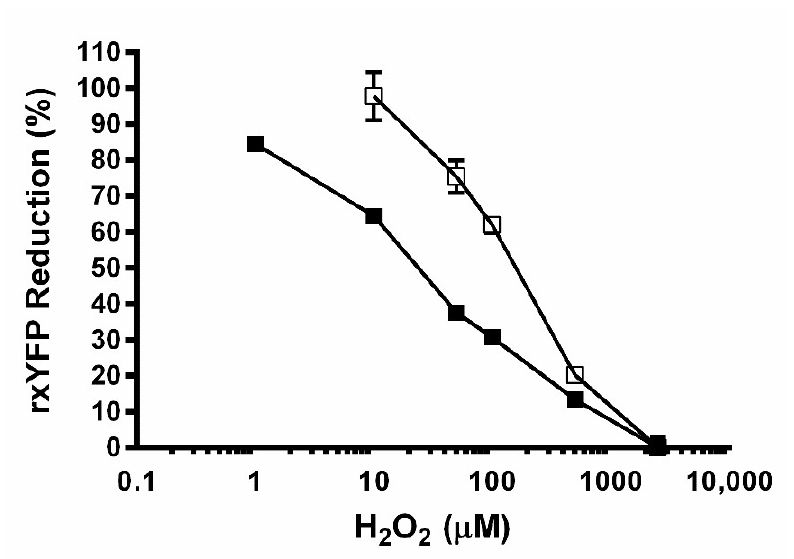
Figure 2. Concentration-dependent response of redox reporter cell lines to H 2 O 2 . CHO-GM-rxYFP ( ■ ) and HEK-293-rxYFP ( □ ) cells were treated with different concentrations of H 2 O 2 for 30 min and the MFI was evaluated by flow cytometry. The data shown correspond to a representative experiment out of two where the relative percentage of rxYFP reduction is expressed as the mean ± SD.